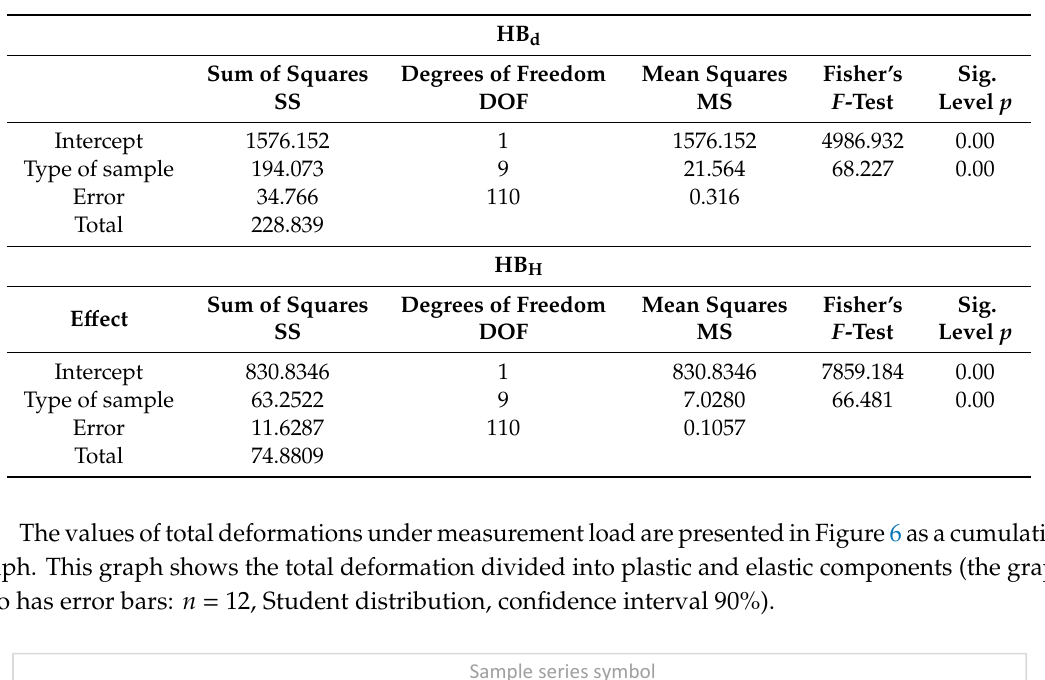
Table 3. The analysis of variance (ANOVA) results.